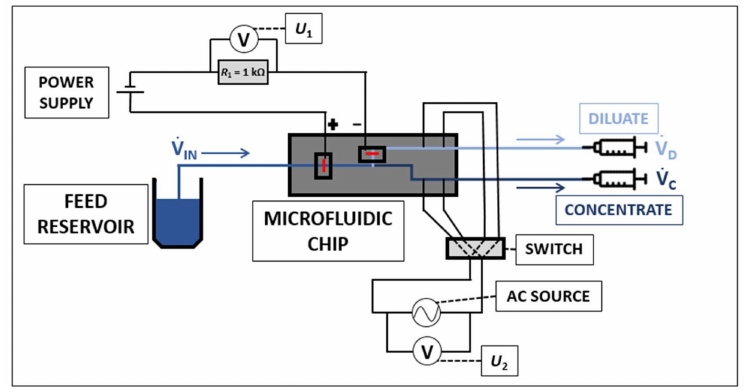
Figure 7. Schematics of the experimental setup used for